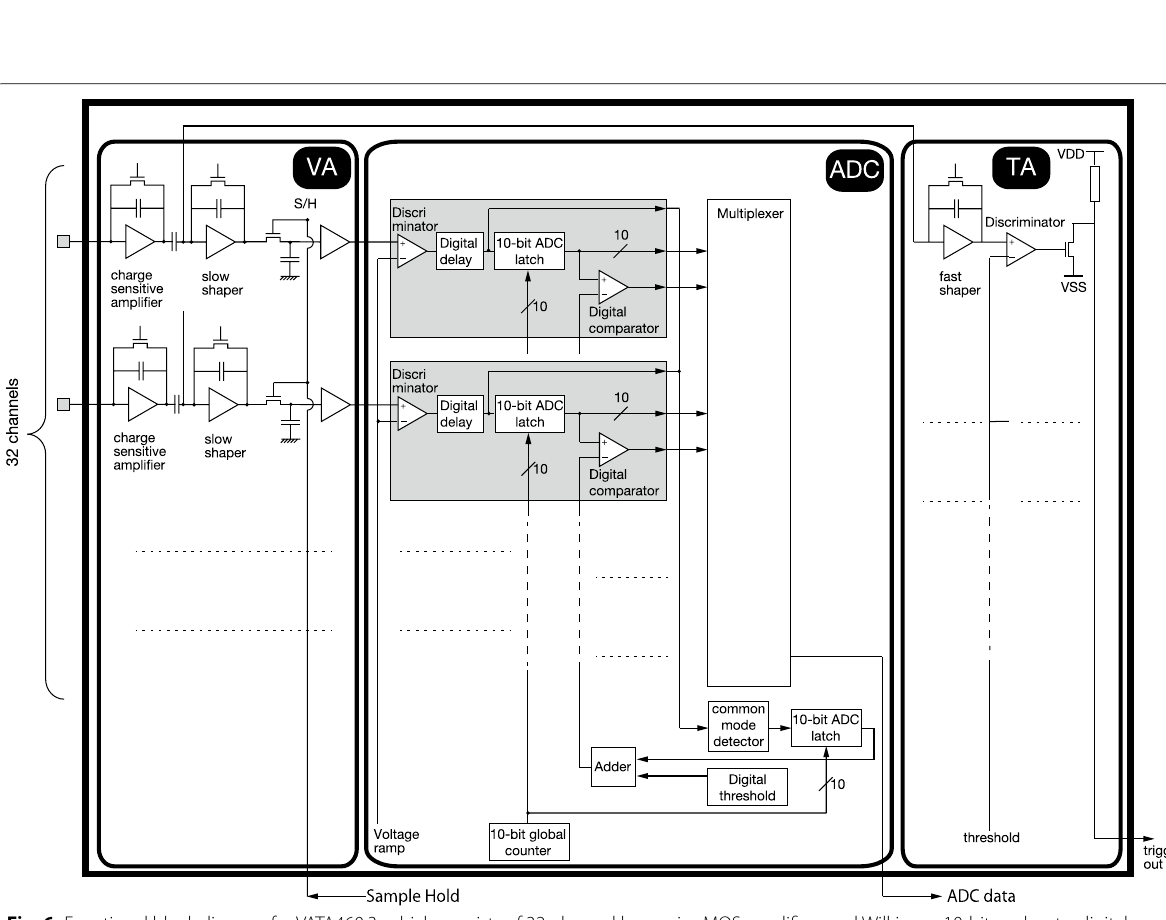
Fig. 6 Functional block diagram for VATA460.3, which consists of 32-channel low-noise MOS amplifiers and Wilkinson 10-bit analog-to-digital converters (ADCs). Each channel includes a charge-sensitive preamplifier, a fast CR-RC shaping amplifier followed by a discriminator generating a trigger signal for the readout sequence, and a slow CR-RC shaping amplifier followed by a sample-and-hold circuit for pulse-height analysis. The digital data from the 32 channels are multiplexed and read out on a serialized digital